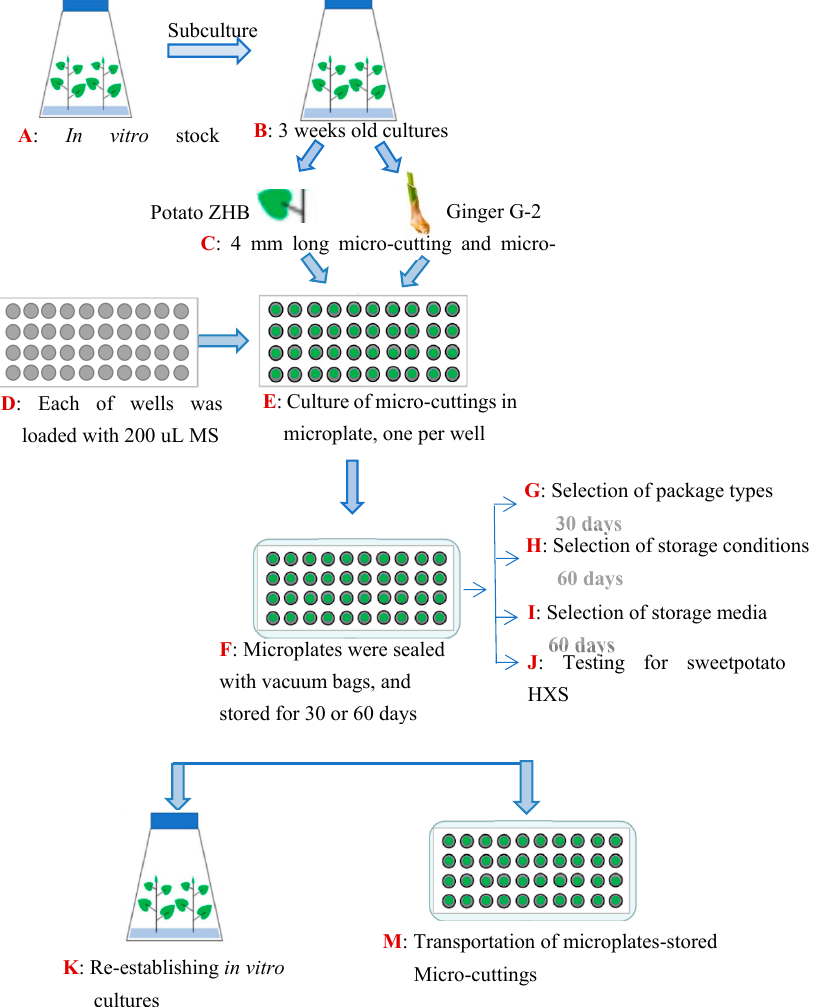
Figure 1. A flow chart of use of microplates for storage and transportation of in vitro micropropagated plant